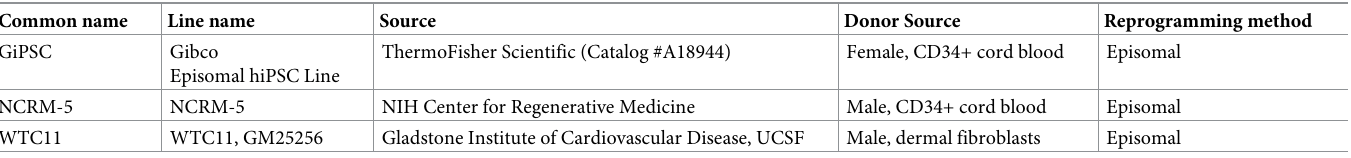
Table 1. Human induced pluripotent stem cell